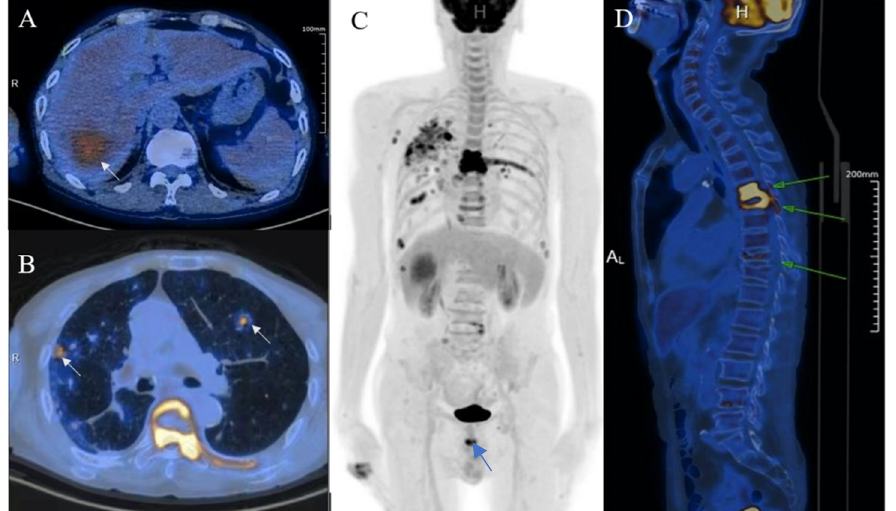
Figure 3. With suspicions of hepatocellular carcinoma (HCC), the patient was urged to undergo fluorine-18-fluro-2-deoxy-D-glucose-positron emission tomography/computed tomography ( 18 F- FDG-PET/CT). The mass showed mild 18 F-FDG uptake with SUVmax of 4.7 (( A ), arrow). Moreover, hypermetabolic nodules in the lung, chest wall, thoracic vertebra, and pelvis were also observed, which indicated metastasis (( B – D ), arrows).